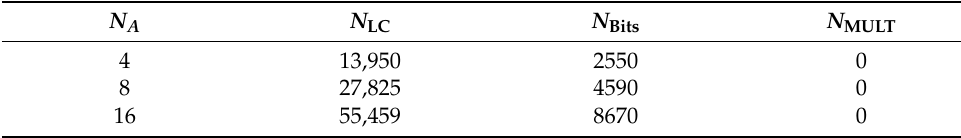
Table 2. Area occupation for the TM.